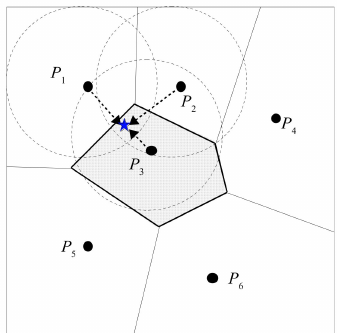
Figure 6. Examples of “positive region” (shaded area) and “negative region” (blank